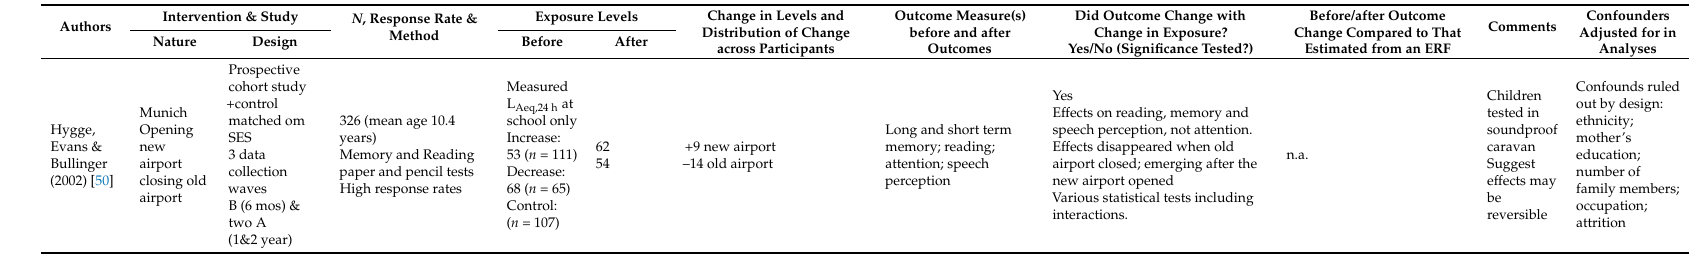
Table 15. New/Closed Infrastructure (Type